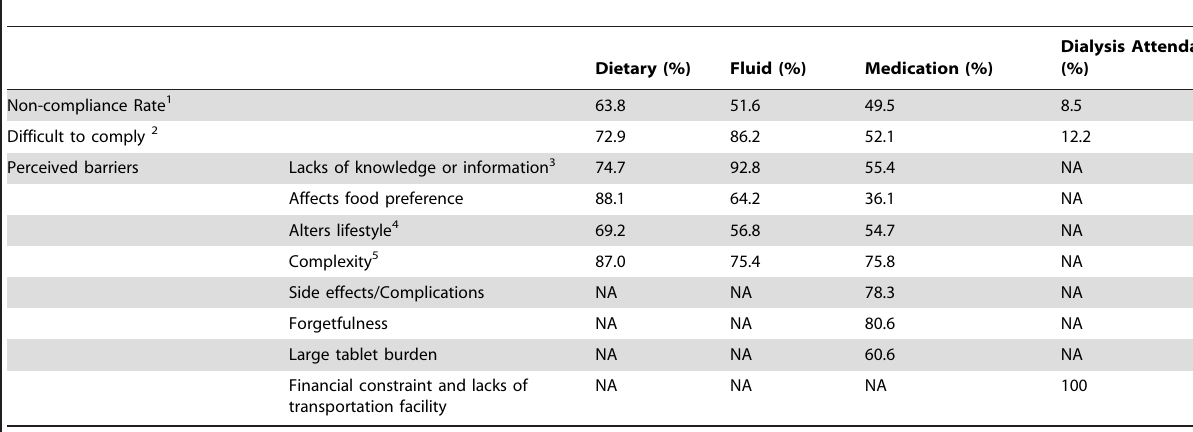
Table 4. Perceived barriers contributing to non-compliance on treatment regimens.